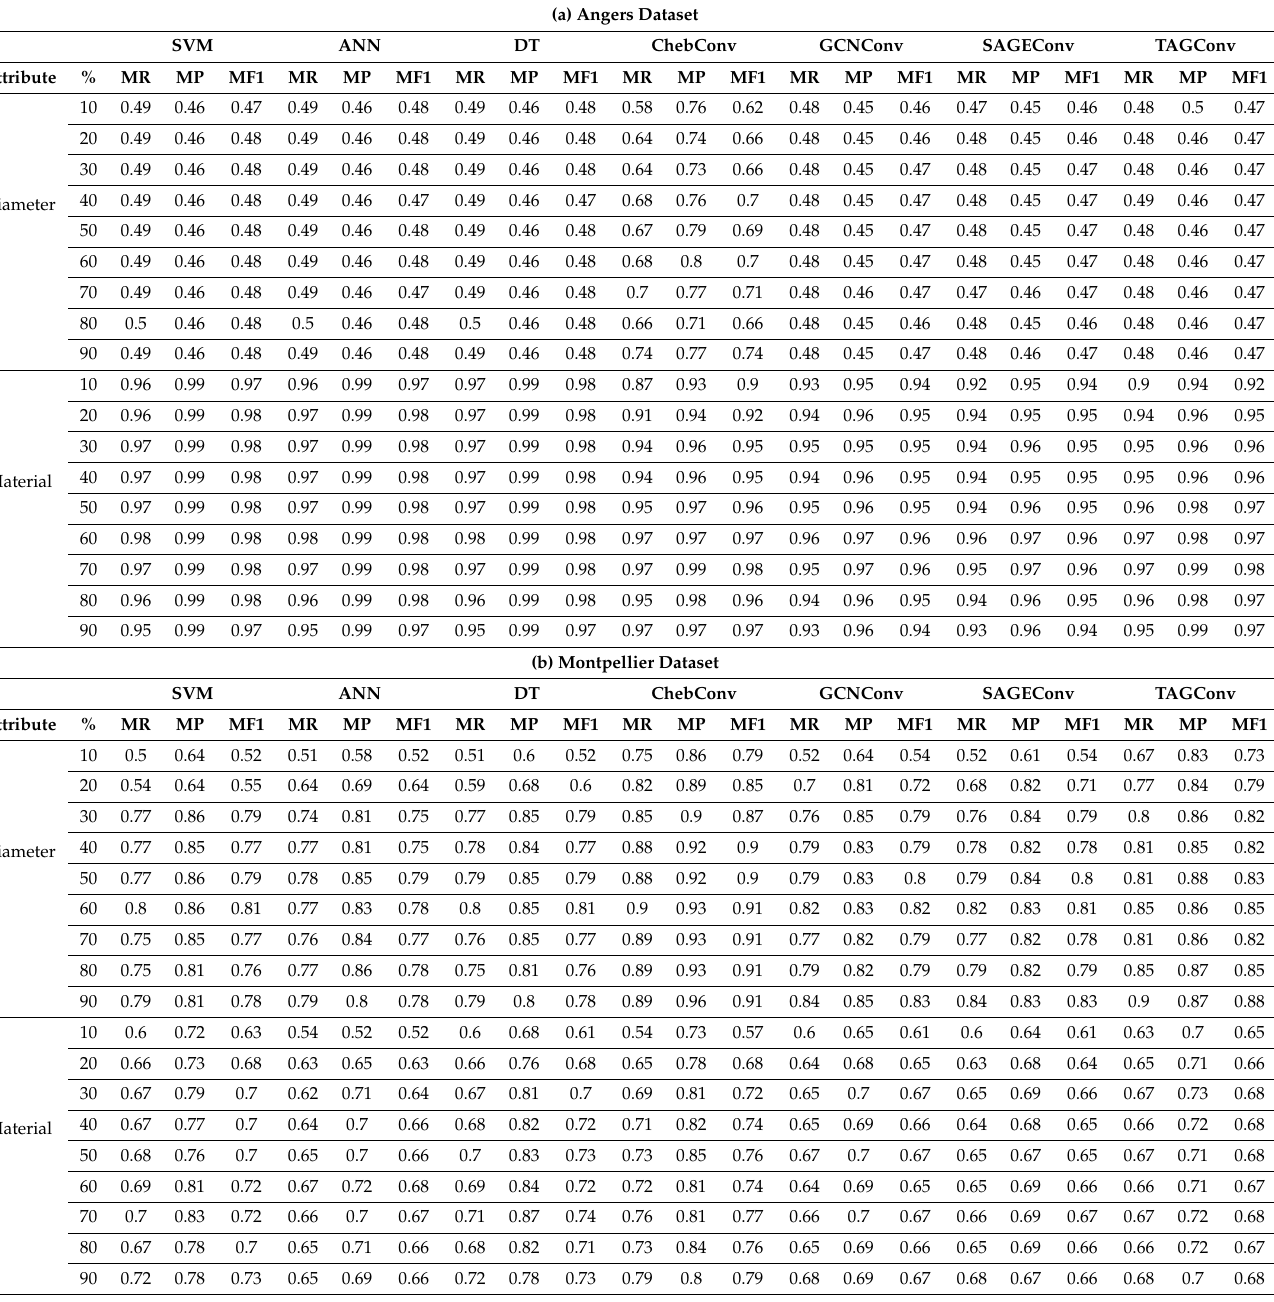
Table 2. Configuration 2. Results obtained for Angers and Montpellier dataset by the seven models in terms of Macro-Recall (MR), Macro-Precision (MP), and Macro-F1 (MF1) scores, for the two classes and with different percentages of the dataset used for training.